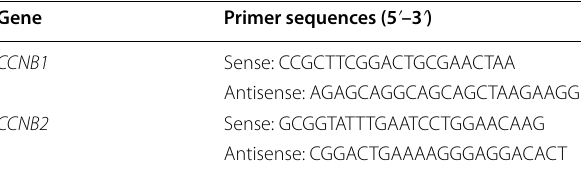
Table 1 Primer sequences Gene Primer sequences (5 ʹ –3 ʹ )